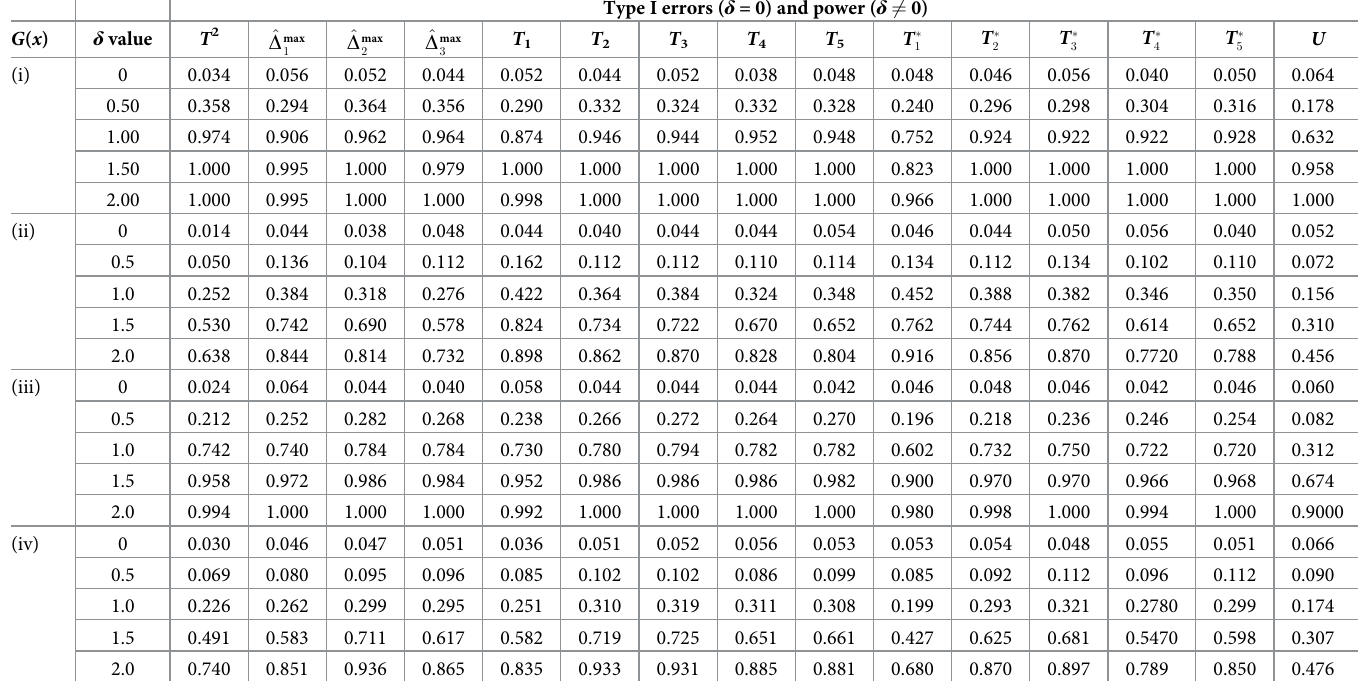
Table 4. Type I errors ( δ = 0) and power ( δ 6¼ 0) given by the investigated test statistics based on permutation approach in detecting location shift between two sam- ples generated from the four pairs of F ( x )and G ( x )with the non-independent variance-covariance matrix and sample sizes n = m = 10.